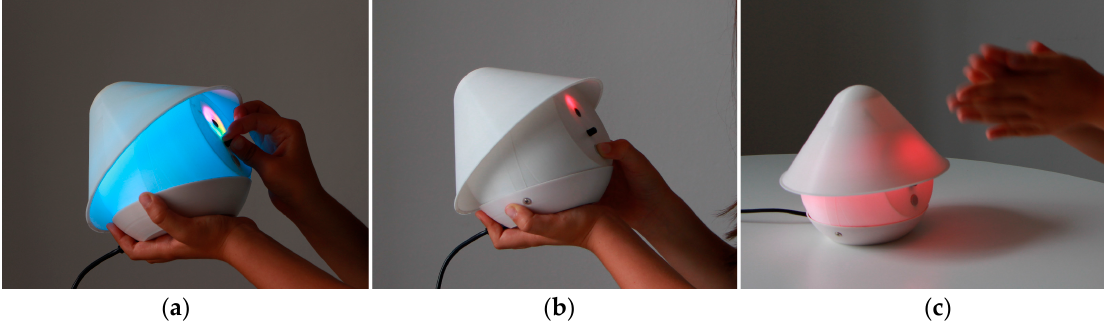
Figure 1. Shybo’s prototype in three phases of interaction. From left: ( a ) colour selection, ( b ) sound recording, and ( c ) making loud sounds to get Shybo scared.